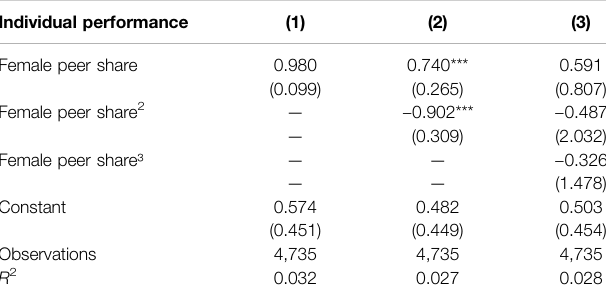
TABLE 3 | Regression results for within-ranks effects for